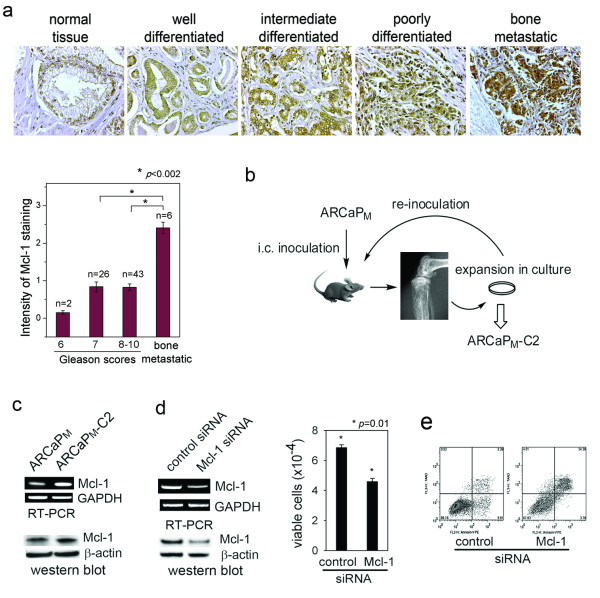
Mcl-1 is a survival factor in human PCa cells. (a) IHC staining of Mcl-1 in human PCa tissue microarray consisting of normal adjacent tissues, primary PCa and bone metastases. (b) Intracardiac (i.c) injection of ARCaPM cells in athymic mice resulted in metastases to bone and soft tissues. The ARCaPM-C2 subclone was derived from metastatic bone tissues after two rounds of intracardiac inoculation of ARCaPM cells. (c) Endogenous Mcl-1 expression in the ARCaPM model was examined by RT-PCR and western blotting analyses. (d) Effect of Mcl-1 siRNA on ARCaPM cell viability. Subconfluent ARCaPM cells on a 6-well plate were transiently transfected with Mcl-1 siRNA (30 nM) for 72 h. Endogenous expression of Mcl-1 at the mRNA and protein levels, and cell viability of ARCaPM cells as counted with trypan blue staining, were significantly inhibited by Mcl-1 siRNA treatment compared to the control. (e) Effects of Mcl-1 siRNA on ARCaPM cell apoptosis. Subconfluent ARCaPM cells were transfected with Mcl-1 siRNA or control siRNA for 72 h, expression of annexin V was measured by FACS.